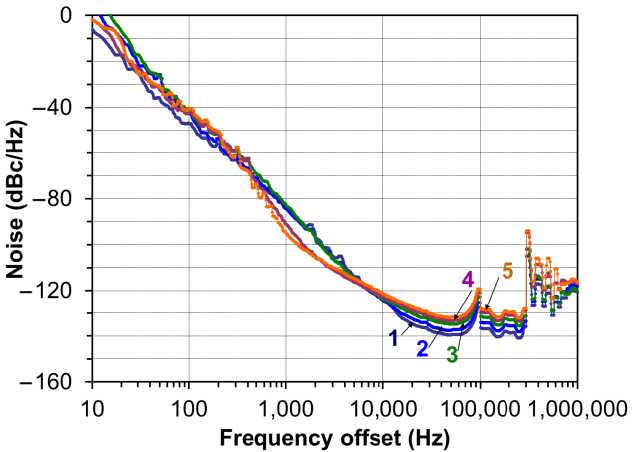
Figure 8. Phase noise in the OEO with the broadband demodulation and tunable YIG filter as a function of the frequency offset at different generation frequencies: curve 1 - 4, 2 - 6, 3 - 8, 4 - 10, and 5 - 12 GHz.